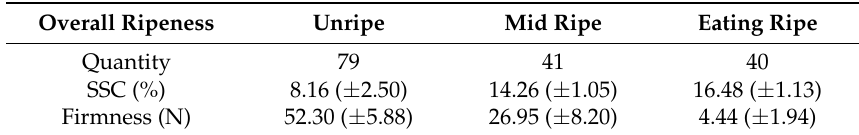
Table 4. Quantity of samples, average values ( ± standard deviation) of SSC and firmness at different ripening stages.